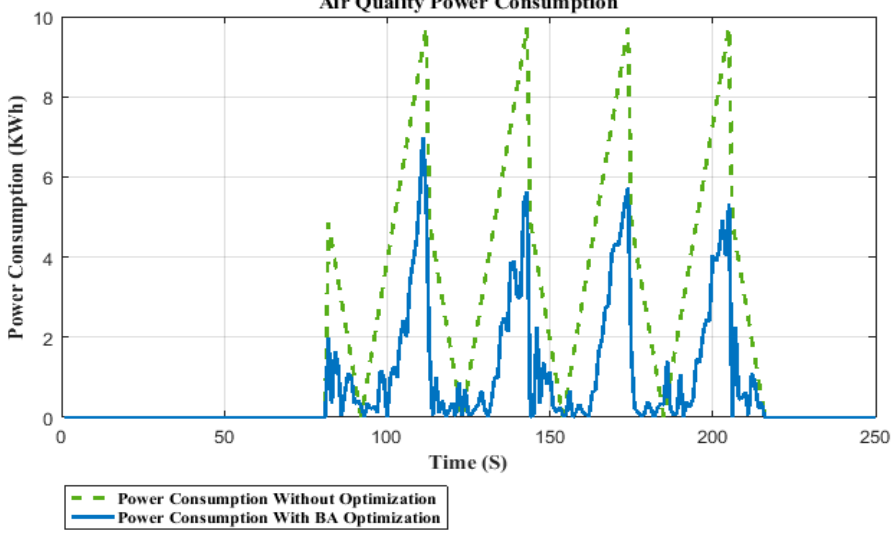
Figure 19. Power consumption for air quality with BA optimization and without BA optimization.